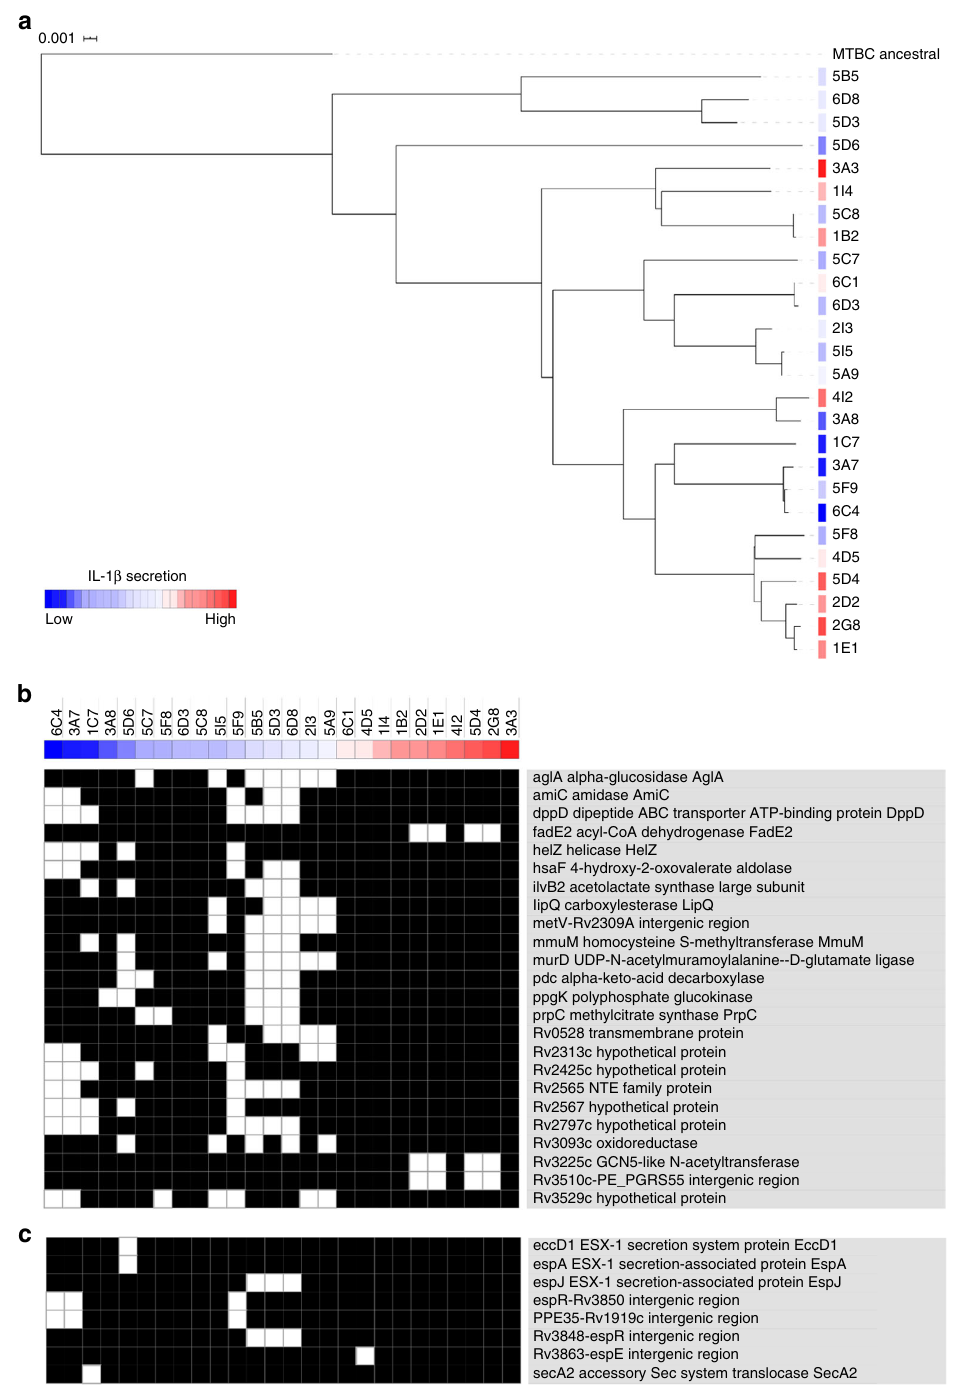
Fig. 2 Common polymorphisms in groups of low-cytokine-inducing M . tuberculosis clinical isolates. Genome-wide analysis was performed for 26 M . tuberculosis clinical isolates with known IL-1 β inducing pro fi les in human PBMCs. a Phylogenetic tree of the isolates constructed with genome-wide SNPs and using maximum likelihood. The color gradient between dark blue (low) and dark red (high) indicates the level of IL-1 β induced by each strain. b Genes with (white) or without (black) polymorphisms exclusively present in >30% of the M . tuberculosis isolates classi fi ed as low or high IL-1 β inducers. c ESX-1 secretion system and associated regulators showing polymorphisms exclusively present in the low or high IL-1 β inducing